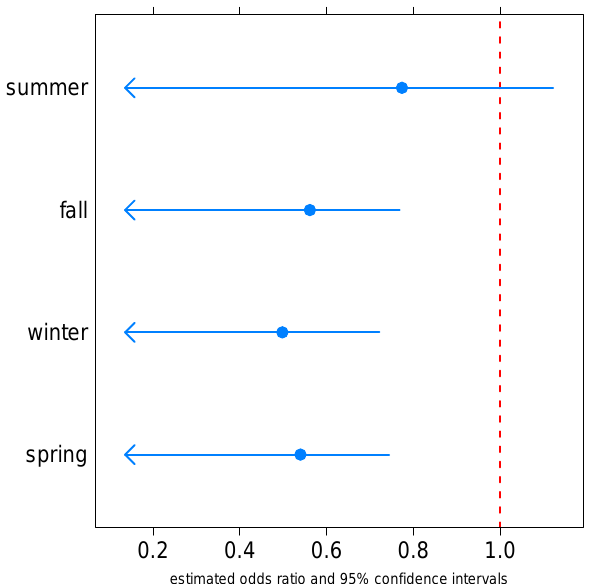
Figure 3. Odds ratios and their one-sided 95% confidence intervals for reduction in any-respiratory- cause preschool absenteeism associated with upper room germicidal light, at four illustrative temperatures—the mean temperature of each of the four